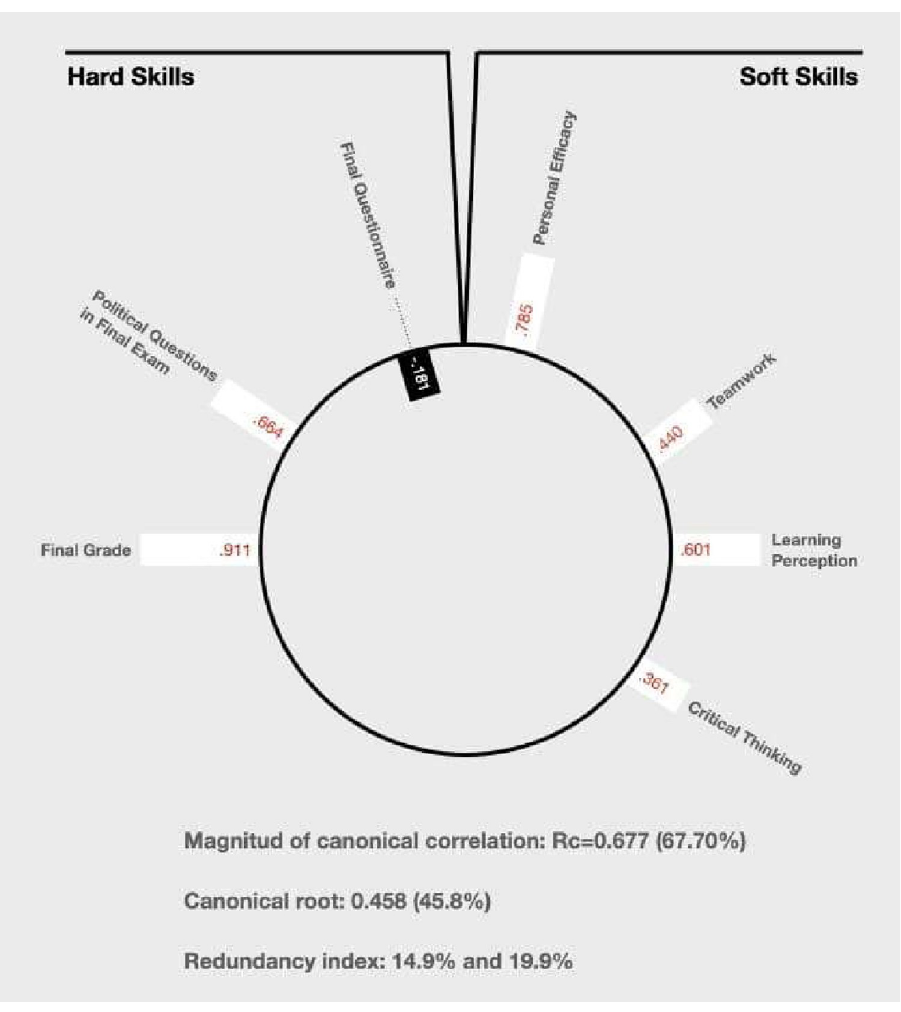
Fig 1. Heliograph canonical